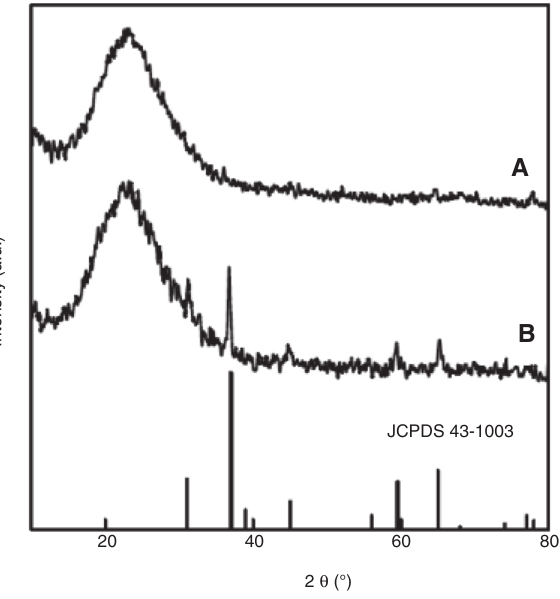
Figure 1 X-ray diffraction (XRD) patterns of: (A) 0.5%